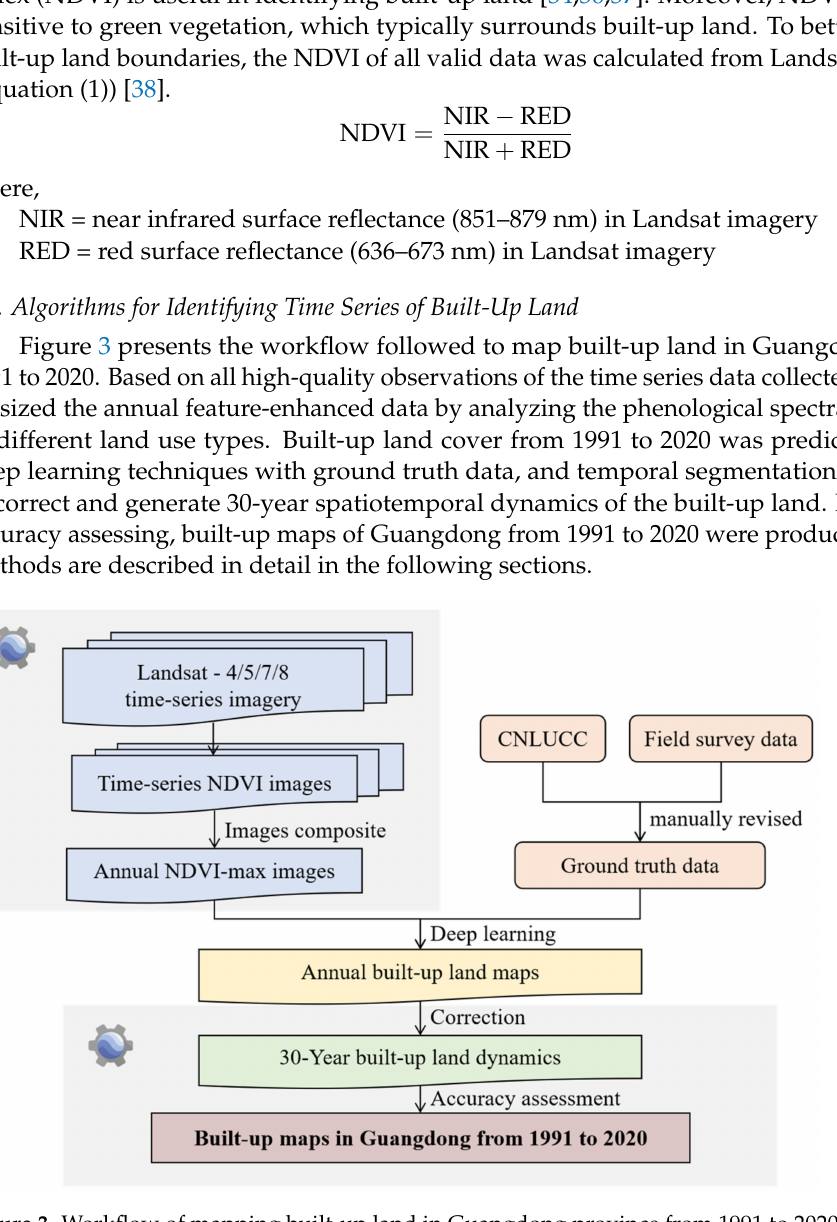
Figure 3. Workflow of mapping built-up land in Guangdong province from 1991 to